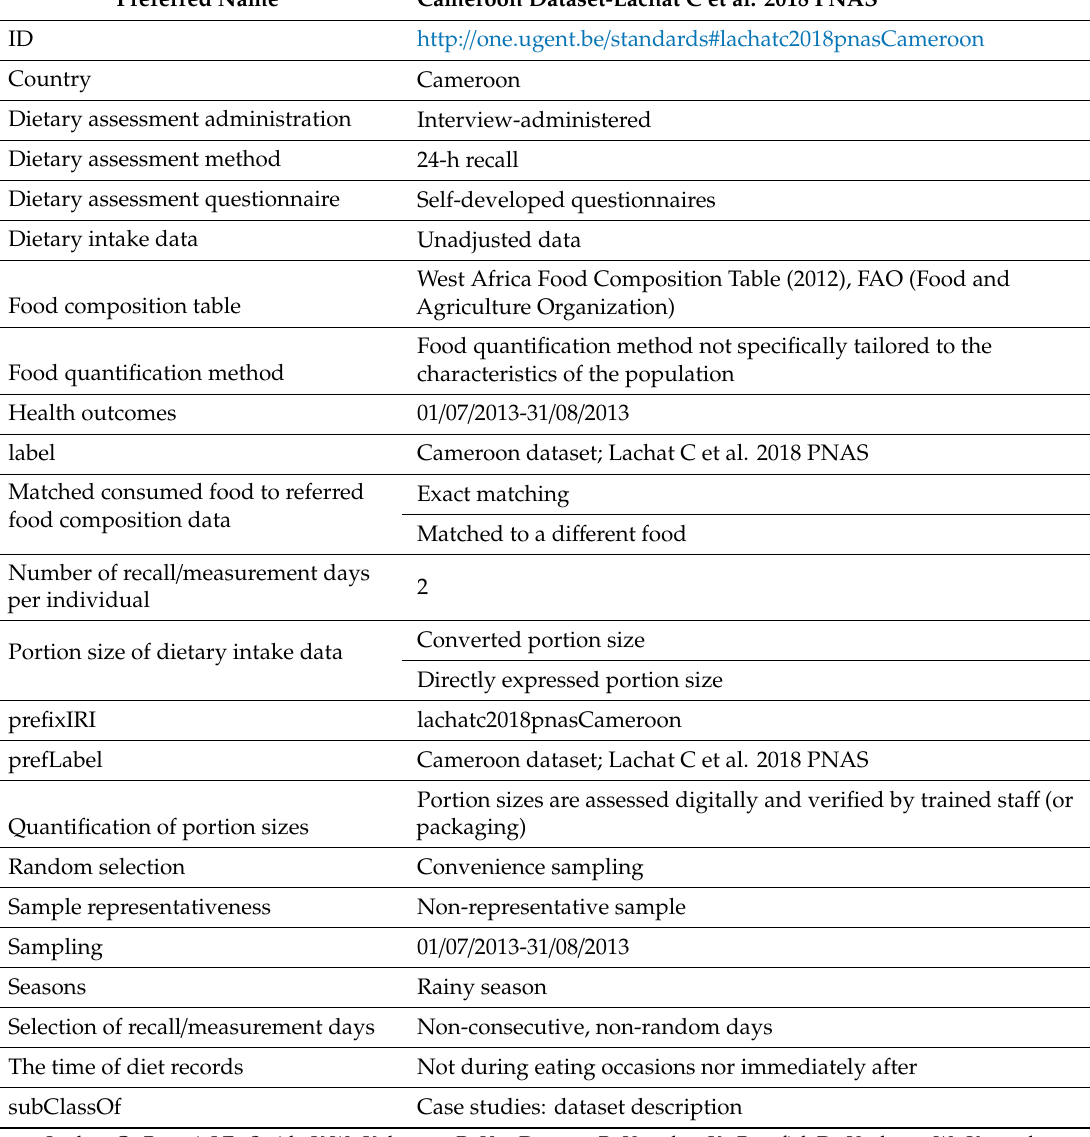
Table A5. Case study: dietary species richness as a measure of food biodiversity and nutritional quality of diet (Lachat et al. 2018), Cameroon dataset description.